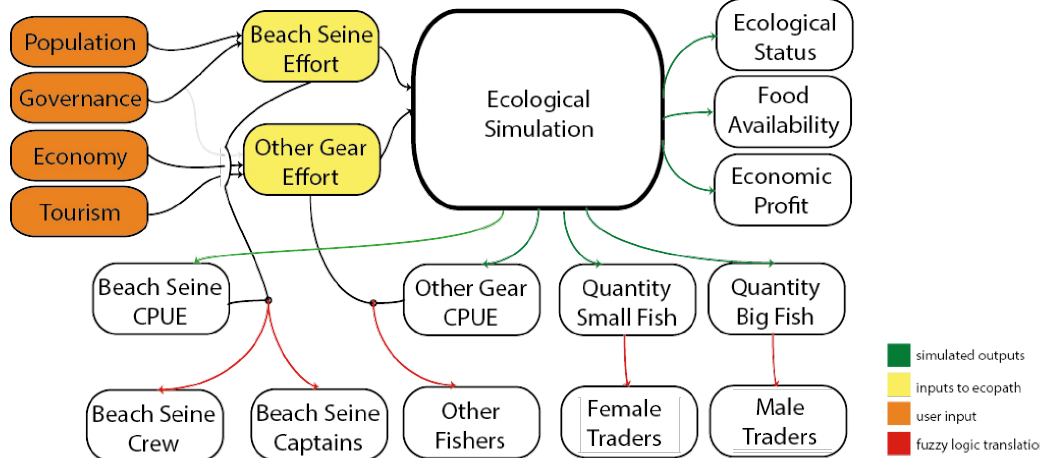
Figure S1. Final structure (after stakeholder’s revisions) of the toy-model used to tradeoff analysis